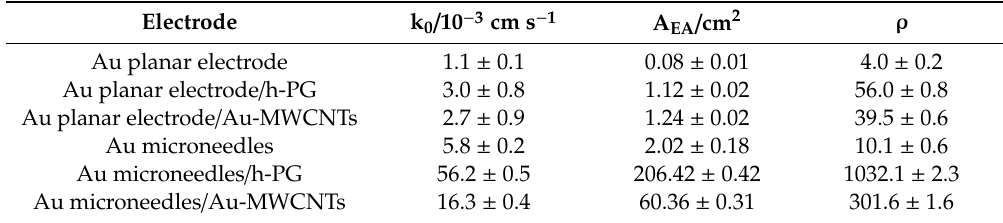
Table 1. Heterogeneous electron transfer rate constant (k 0 ), real electroactive area (A EA ), and roughnesss factor ( ρ ) of the gold planar electrode and the gold microneedles-based electrode before and after the electrodeposition of h-PG and Au-MWCNTs. A geo planar Au electrode = 0.020 cm 2 ; A geo microneedle electrode = 0.2 cm 2 .